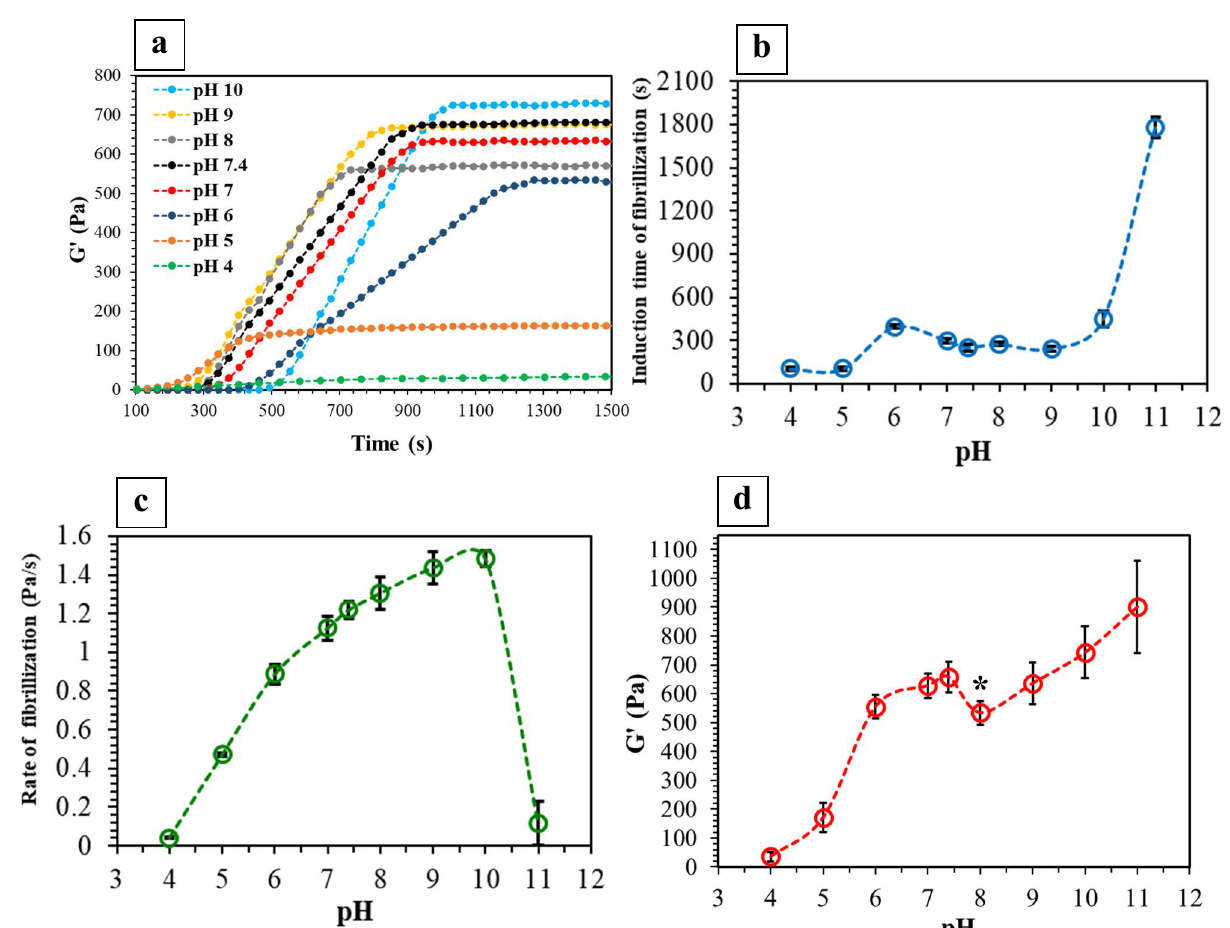
Figure 2. Real-time rheological measurement of collagen gelation: ( a ) Shear storage modulus (G (cid:48) ) of collagen solutions of various pH as a function of time at 37 ◦ C (note that the curve of pH 11 could not be presented here along with other curves due to its long gelation). ( b ) Induction time, ( c ) rate of fibrillization, and ( d ) G (cid:48) of the HHC gels, as a function of pH at 37 ◦ C (* p < 0.05; n =